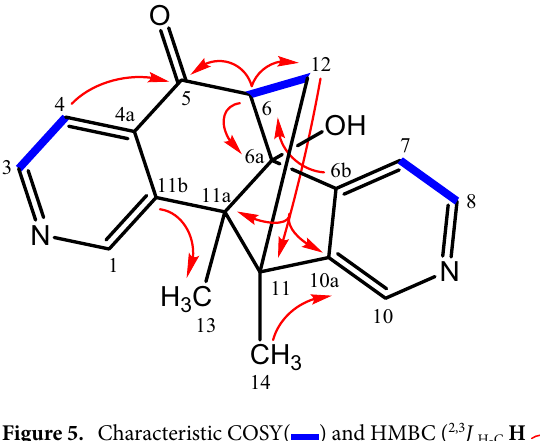
Figure 5. Characteristic COSY( ) and HMBC ( 2,3 J H-C H C ) correlations of 7